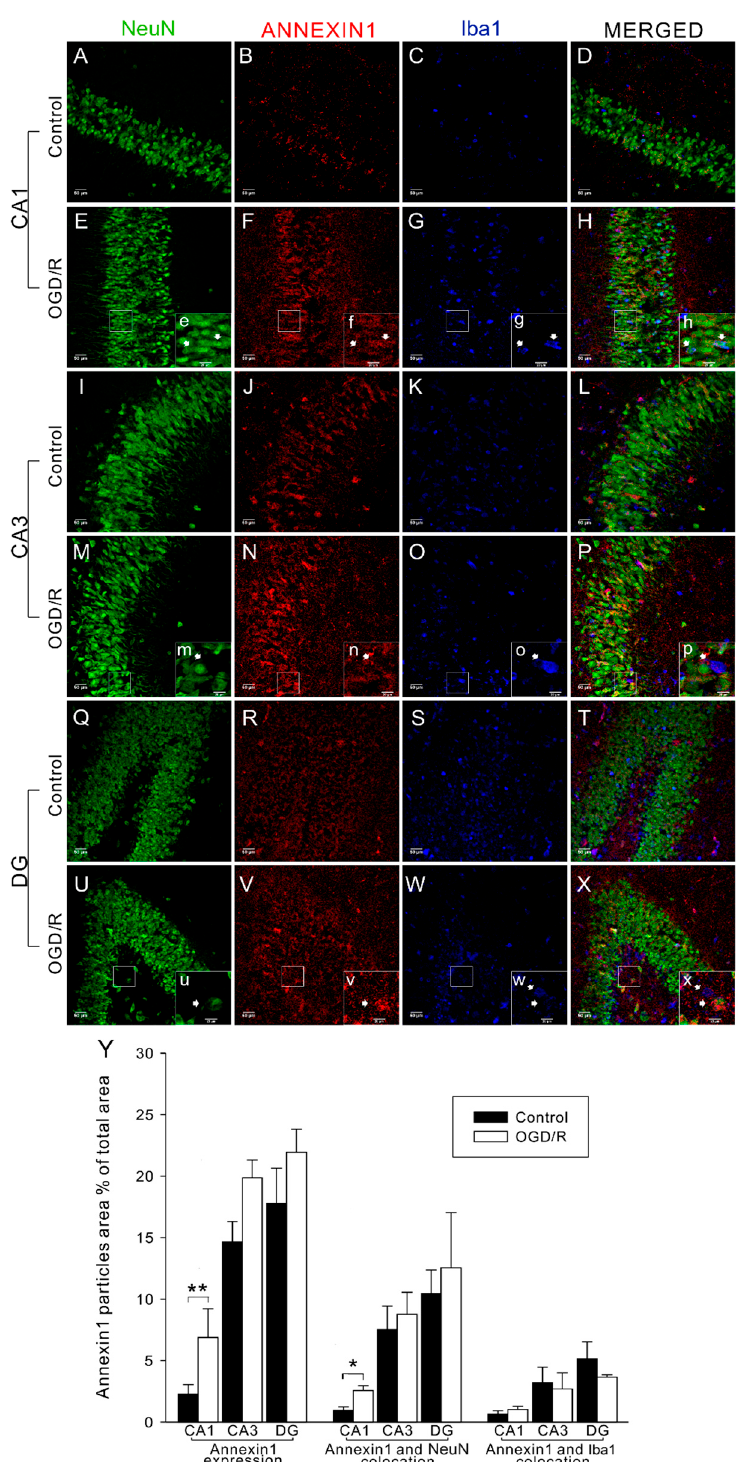
Figure 1. Immunofluorescence imaging revealed that annexin-1 (ANXA1) expression was increased by oxygen–glucose deprivation/reperfusion (OGD/R) in hippocampal slices. ( A – X ) Examples of neuron-specific nuclear protein (NeuN)-labeled neurons ( green ), ANXA1-positive particles ( red ), and ionized calcium binding adapter molecule 1 (Iba1)-labeled microglia ( blue ); in each picture, the right large area with lowercase letter is enlarged from the left small area in white box; the white arrows point at labeled cells and the corresponding area; scale bar: 50 μ m; ( Y ) Fluorescence analysis revealed ANXA1 expression level and the level of ANXA1 co-localization with NeuN or Iba1 in CA1, CA3, and dentate gyrus (DG). The bars indicate the mean ± standard error of the mean (SEM) ( n = 5–8). * p < 0.05, ** p < 0.01.